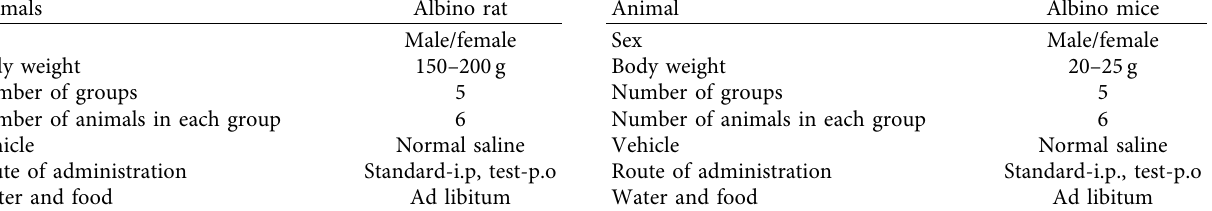
Table 1: Material and method.